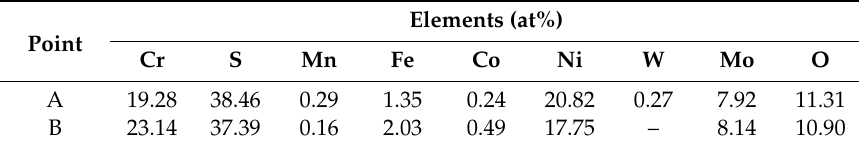
Figure 6. SEM surface micrographs of the corrosion products of: ( a ) C22 alloy; ( b ) C22 laser coating corroded in reducing atmosphere for 108 h at 450 ◦ C. Table 3. EDS results for the typical phases of C22 alloy and C22 laser coating corroded in reducing atmosphere for 108 h at 450 ◦ C in Figure 6.